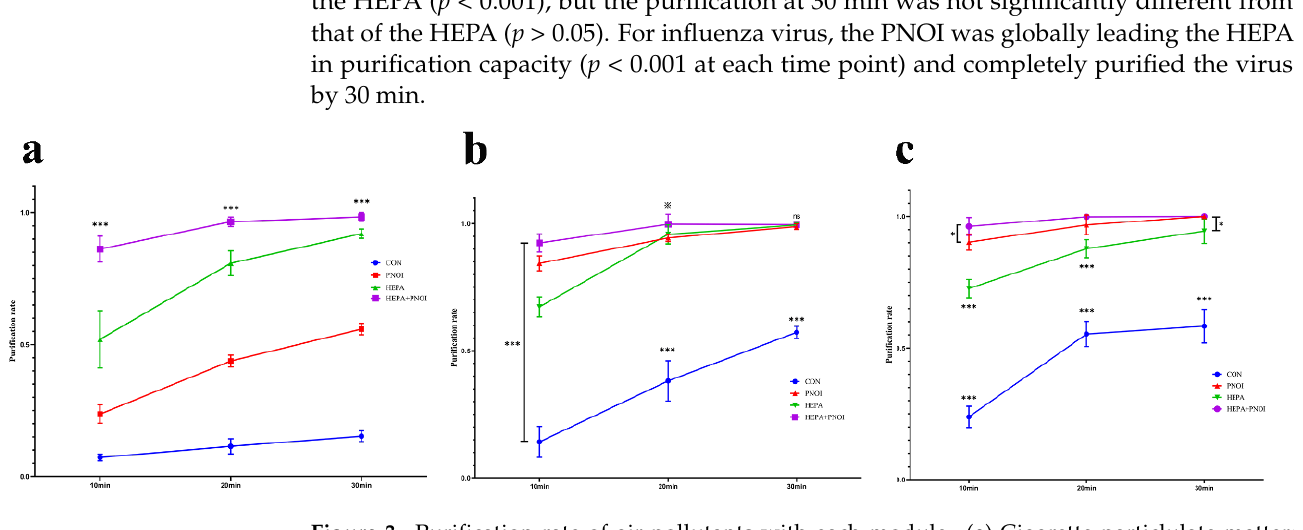
Figure 3. Purification rate of air pollutants with each module. ( a ) Cigarette particlulate matter; ( b ) S. albus ; ( c ) influenza virus. The statistical difference for the last time of different modules is analyzed (ns: no significance; *: p < 0.05; ***: p < 0.001).